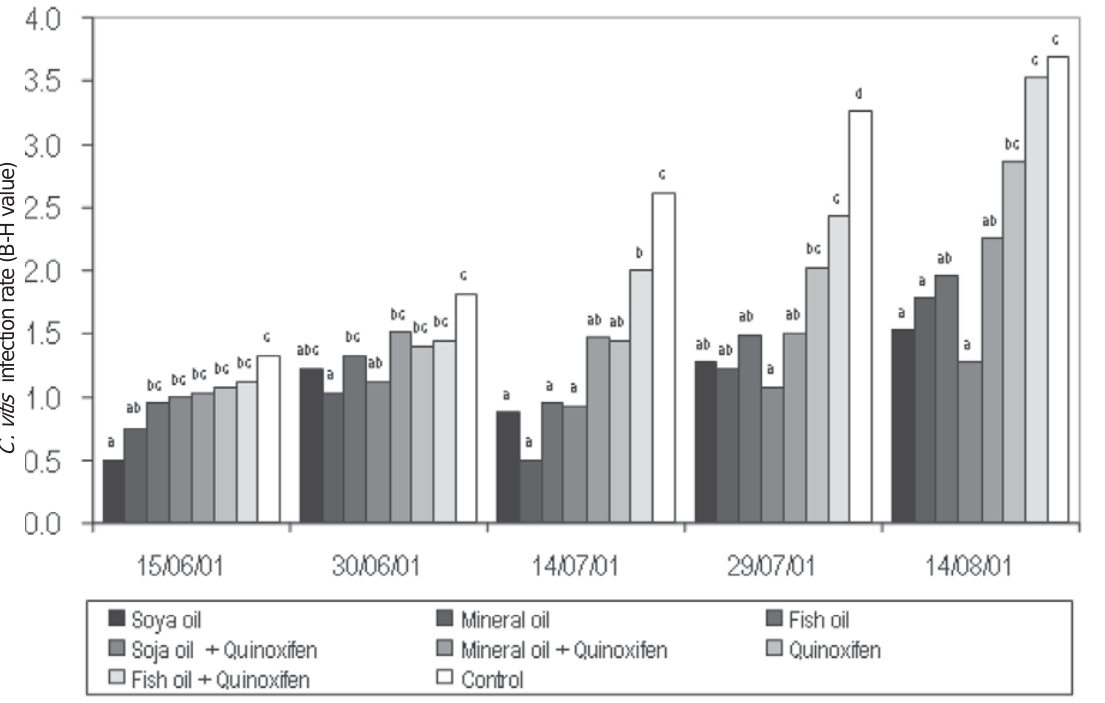
Fig. 4. Mean Calepitrimerus vitis infection rate (Barrat-Horsfall scale) at different times after oil spraying in a field experiment (Tempranillo vines).